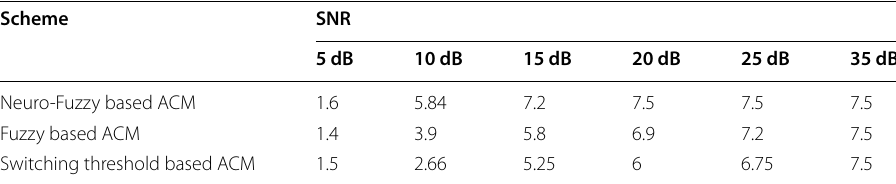
Table 10 Data rate comparison of the proposed scheme to different existing models at atarget BER 10 − 2 =